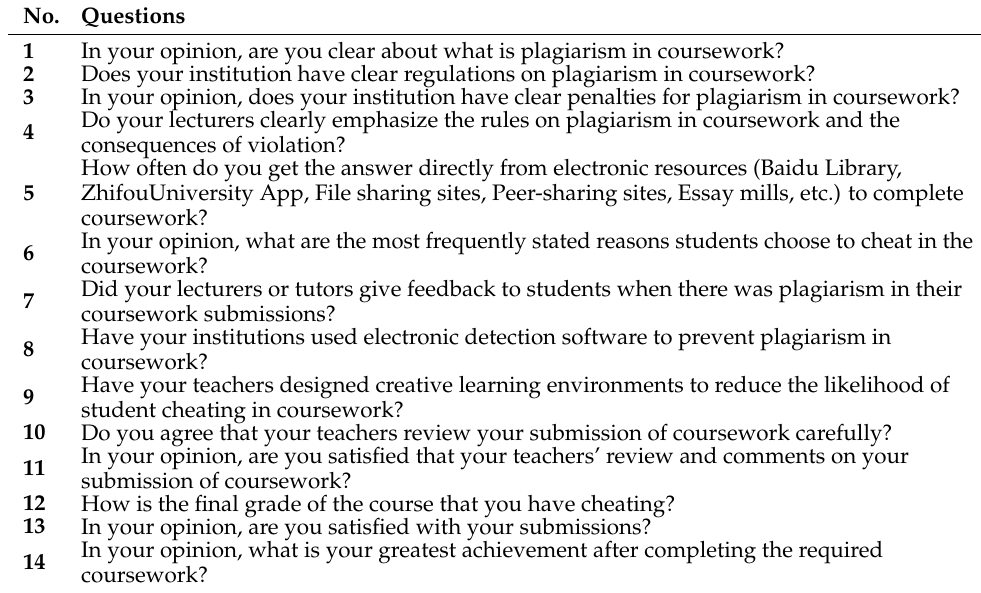
Table 1. Main questionnaire for students.